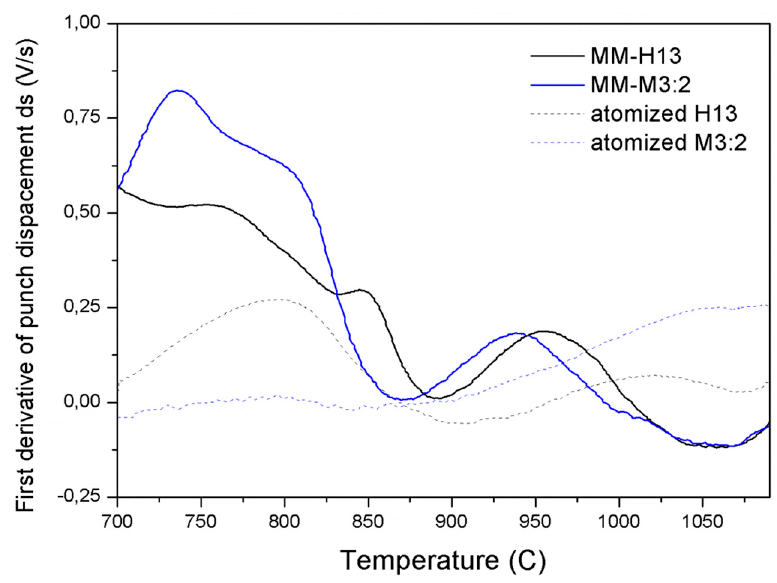
Figure 6. The lower punch displacement during the SPS of MM and the as-atomized base steels.